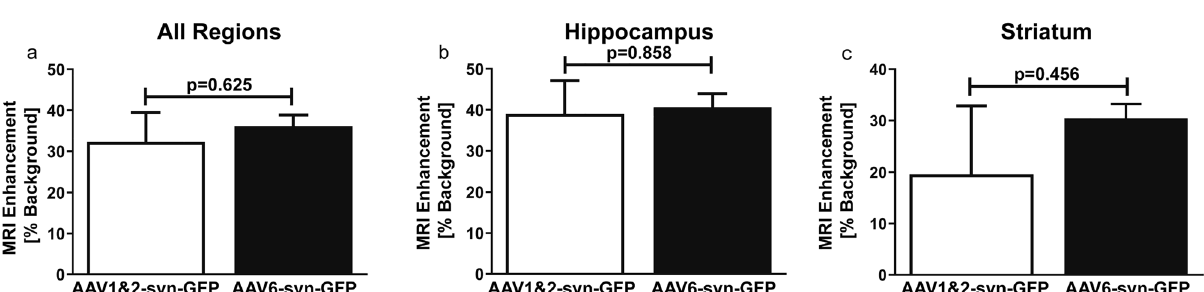
Figure 5. Blood–brain barrier opening is not significantly different between adeno-associated virus (AAV) groups. The mean MRI enhancements of the focal spots generated by FUS were not significantly different between the AAV6-syn-GFP and AAV1&2-syn-GFP experimental groups ( a ) . There was also no difference detected in enhancement of the focal spots targeting the hippocampus specifically ( b ), nor the striatum ( c ) . MRI enhancement is expressed as percent increase intensity over background. Data is represented as the mean ± SEM, n = 9 focal spots per group ( a ), n = 5 per group for the hippocampus ( b ) , n = 4 per group for the striatum ( c